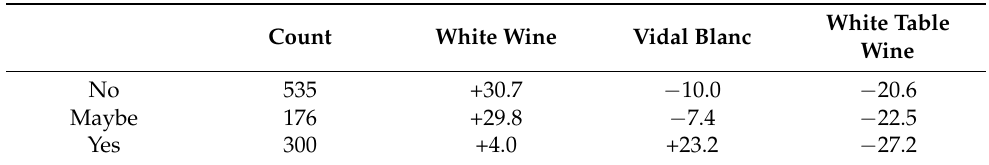
Table 6. Participant responses to the question how familiar they are with the varietal Vidal blanc, and the mean utility scores for each response group.